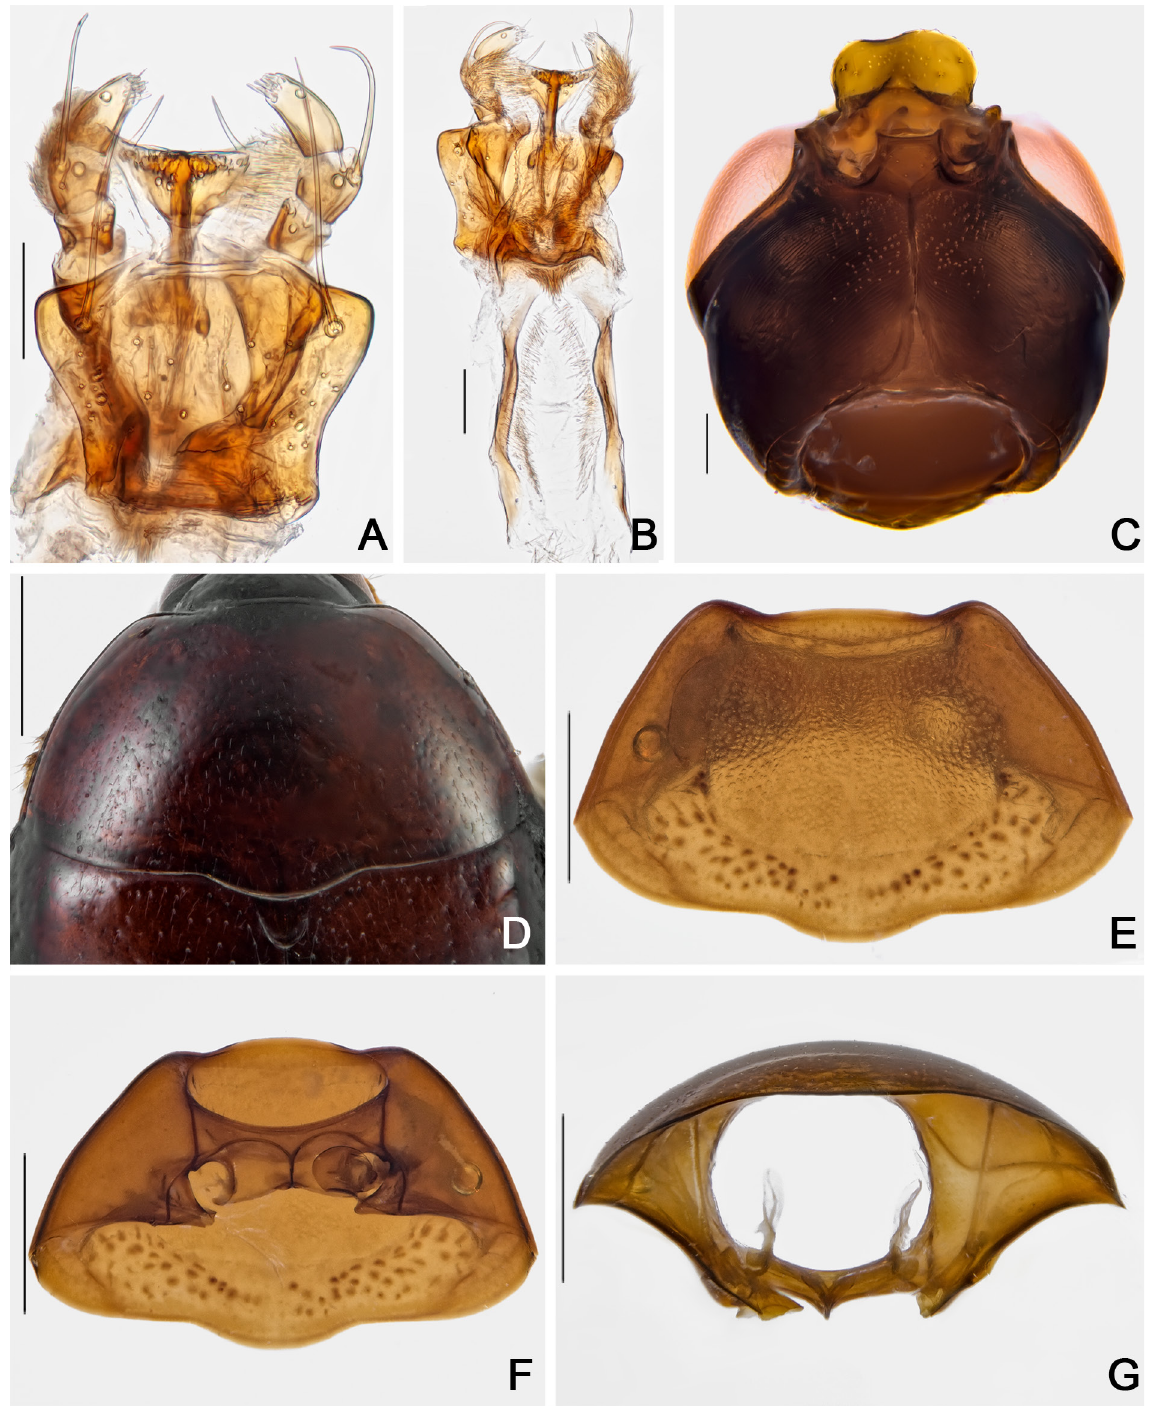
Fig. 24. Cyparium loebli sp. nov. A–C, E–G . Paratype, ♂ (CELC). D . holotype, ♂ (CELC). A . Labium. B . Hypopharynx. C . Head, ventral view. D–E . Pronotum, dorsal view. F . Prothorax, ventral view. G . Prothorax, inner view. Specimens collected at Mata do Paraíso, Viçosa (MG, Brazil). Scale bars: A–B = 0.05 mm; C = 0.1 mm; D–G = 0.5